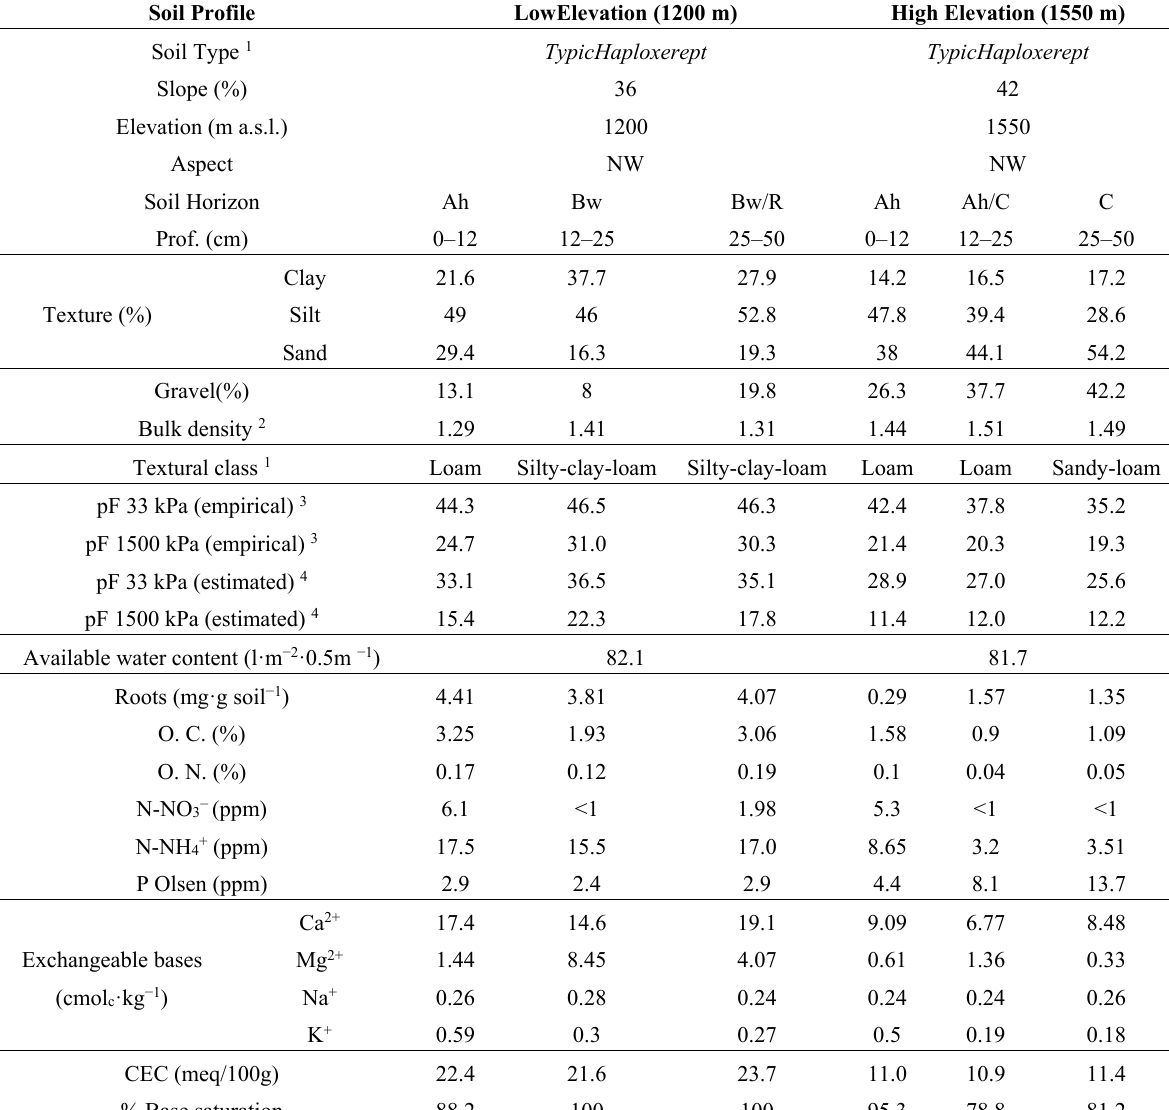
Table 1. Morphological, physical and chemical properties of the studied soil profiles. 1 [21]; 2 [22]; 3 Richards’ pressure membrane; 4 [21]. Available water content = water content at field capacity - water content at permanent wilting